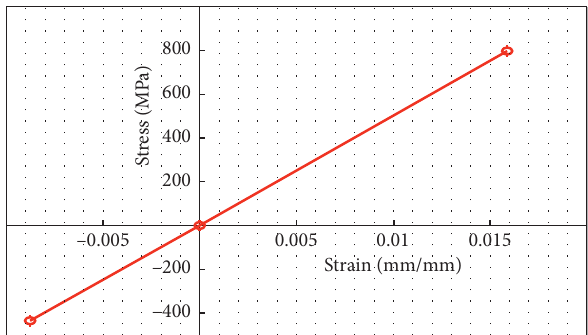
Figure 6: Linear elastic behavior of the GFRP